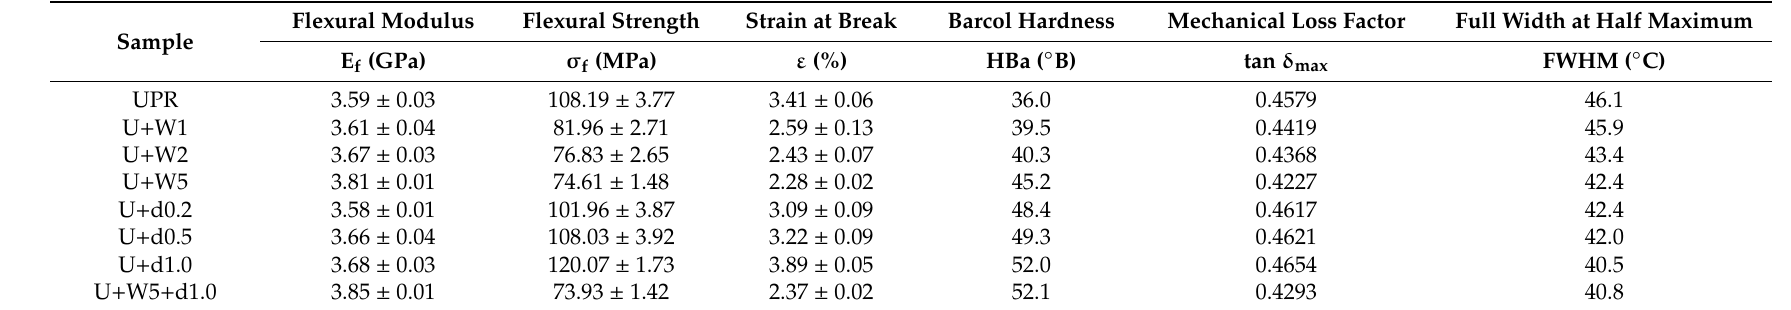
Table 2. Mechanical and thermomechanical data of the samples before accelerated aging test.